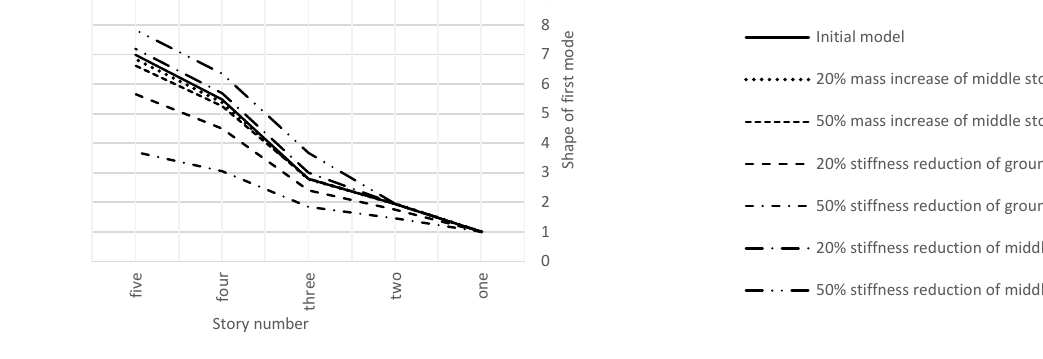
Fig. 6. shape of first mode in 5 story frame.